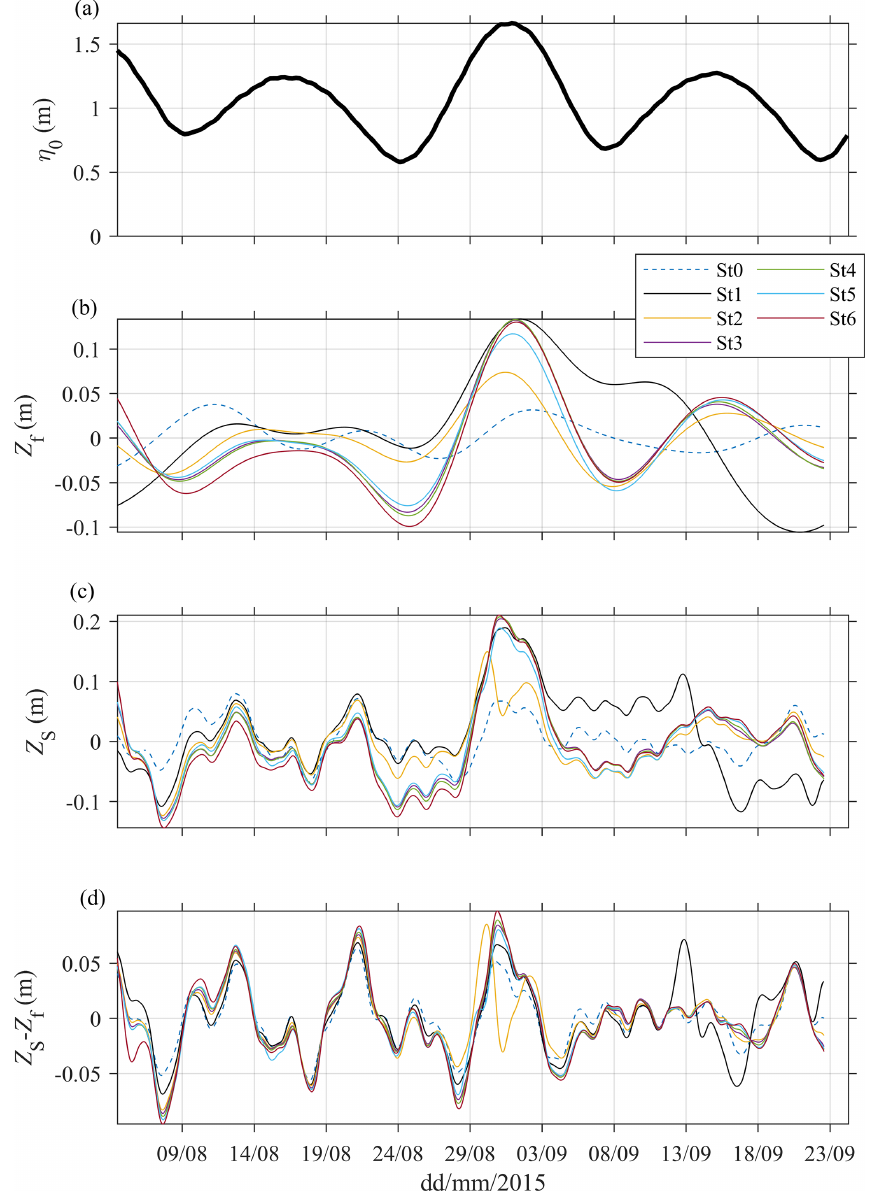
Figure 2. (a) Tidal amplitude ( η 0 , m) near the mouth (St0), (b) low-pass filtered (11d) water level ( Z f , m) at stations St0–6 along the estuary, (c) low-pass filtered (40h) water level ( Z s , m) at St0–6, and (d) residual water level Z s − Z f .